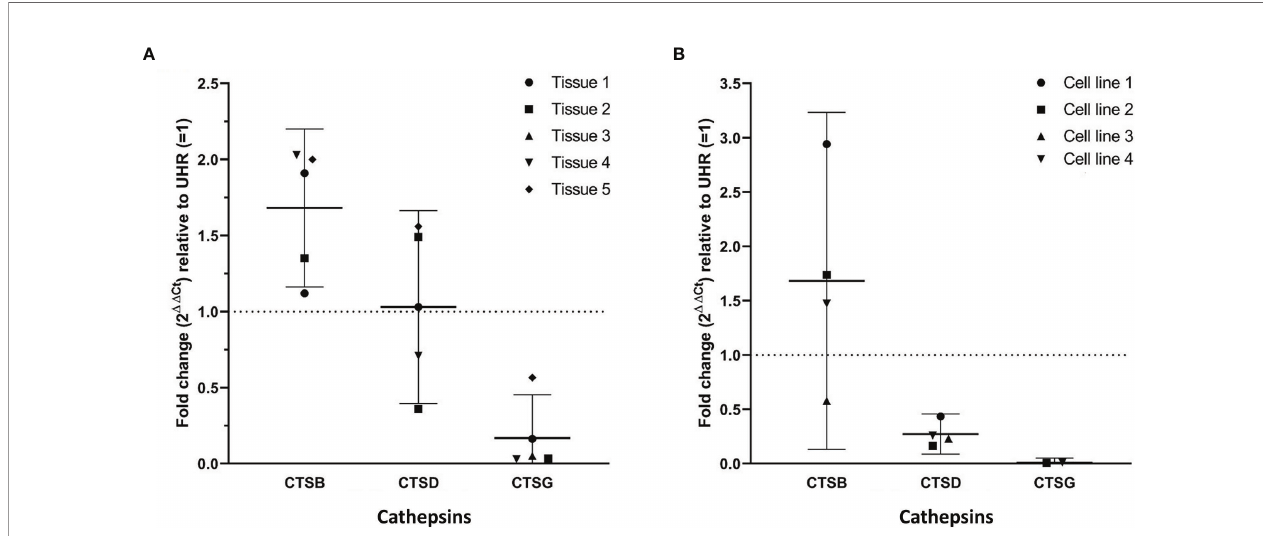
FIGURE 3 | Graphs showing 2 DD Ct values of RT-qPCR runs performed on fi ve snap-frozen metastatic cutaneous head and neck squamous cell carcinoma (mHNcSCC) tissue samples (A) and four mHNcSCC-derived primary cell lines (B) , amplifying transcripts for cathepsin B, cathepsin D and cathepsin G. DD Ct was calculated by normalizing CT values of cathepsins D, B and G to that of the reference genes GAPDH and PUM1, and then expressing this relative to the D Ct of healthy UHR. Error bars: 95% con fi dence